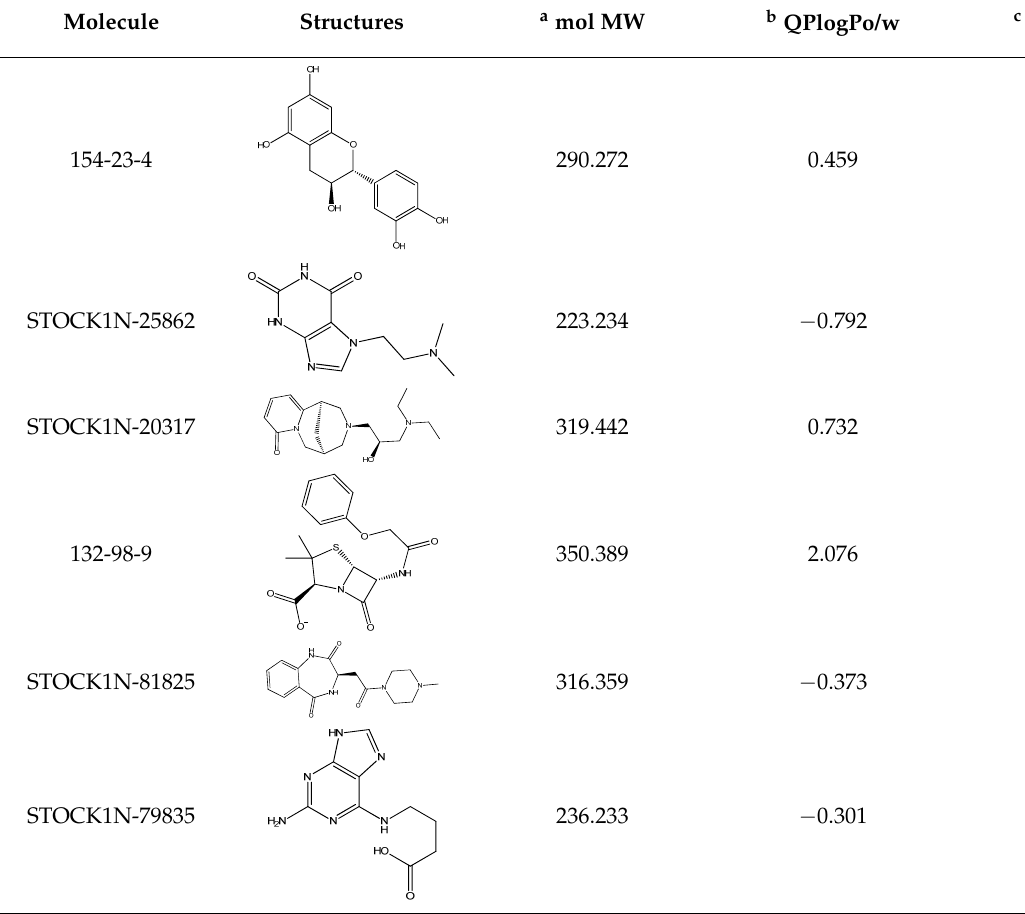
Table 2. The structures and ADME properties of the 12 top ligands. Molecule Structures